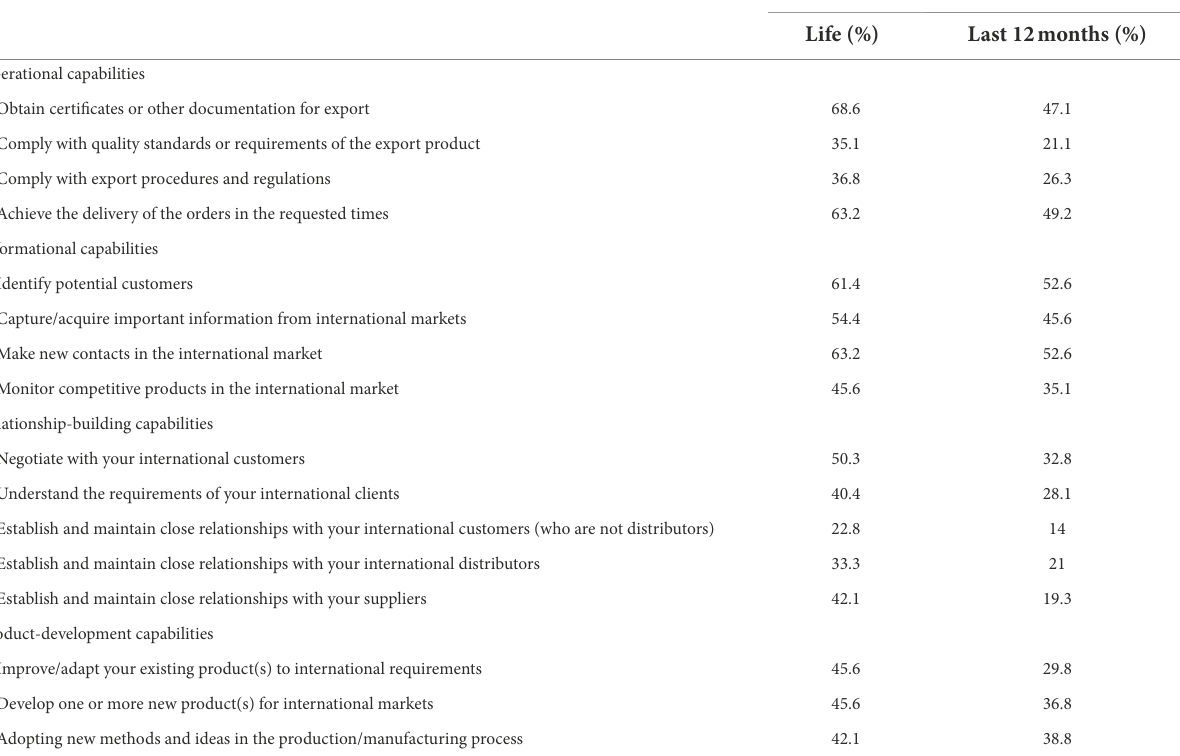
Prevalence Life (%) Last 12 months (%)